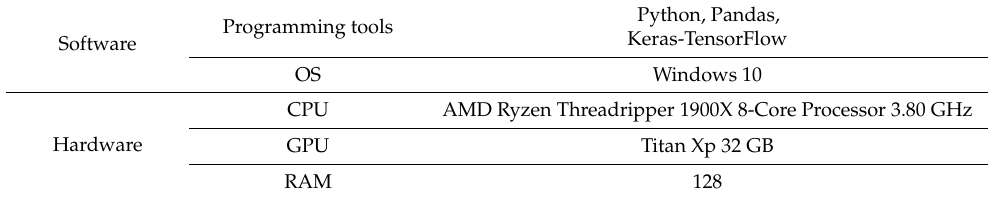
Table 1. Software and hardware